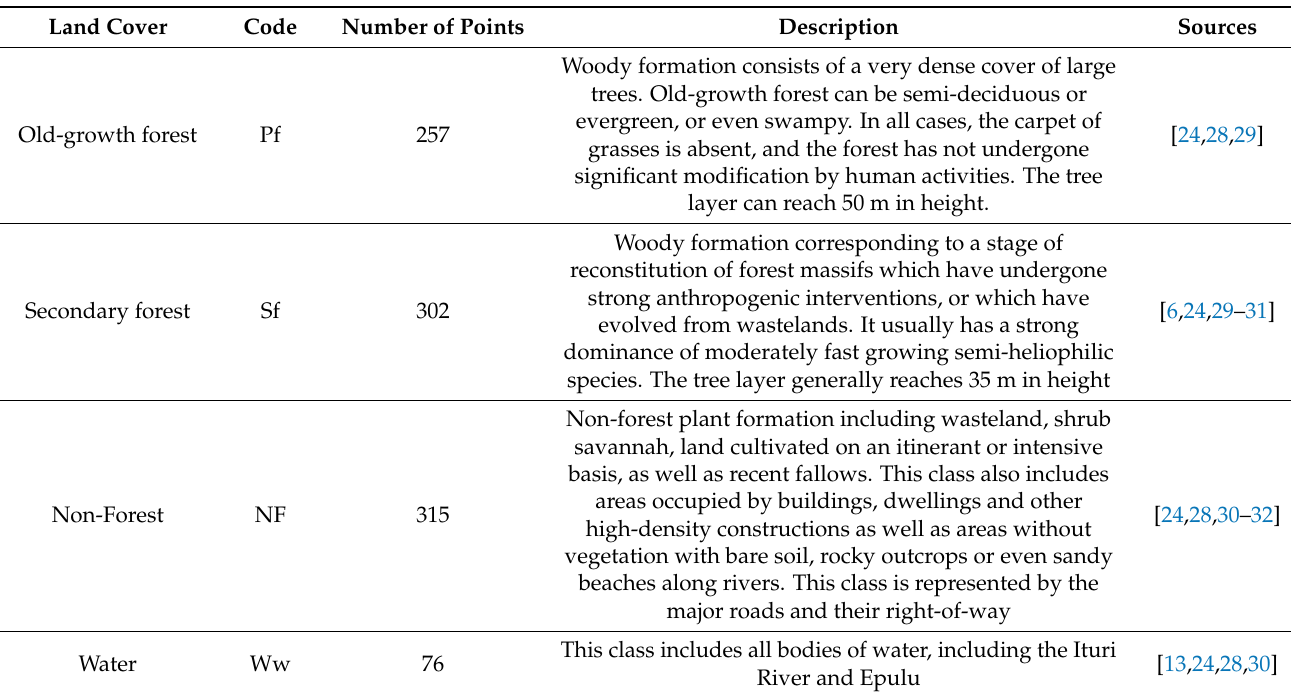
Table 1. Description of land use